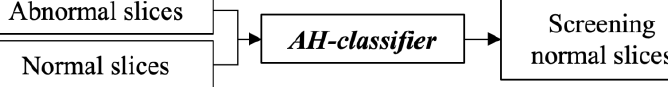
Figure 3. Flow of AH lesion detection using AI models.